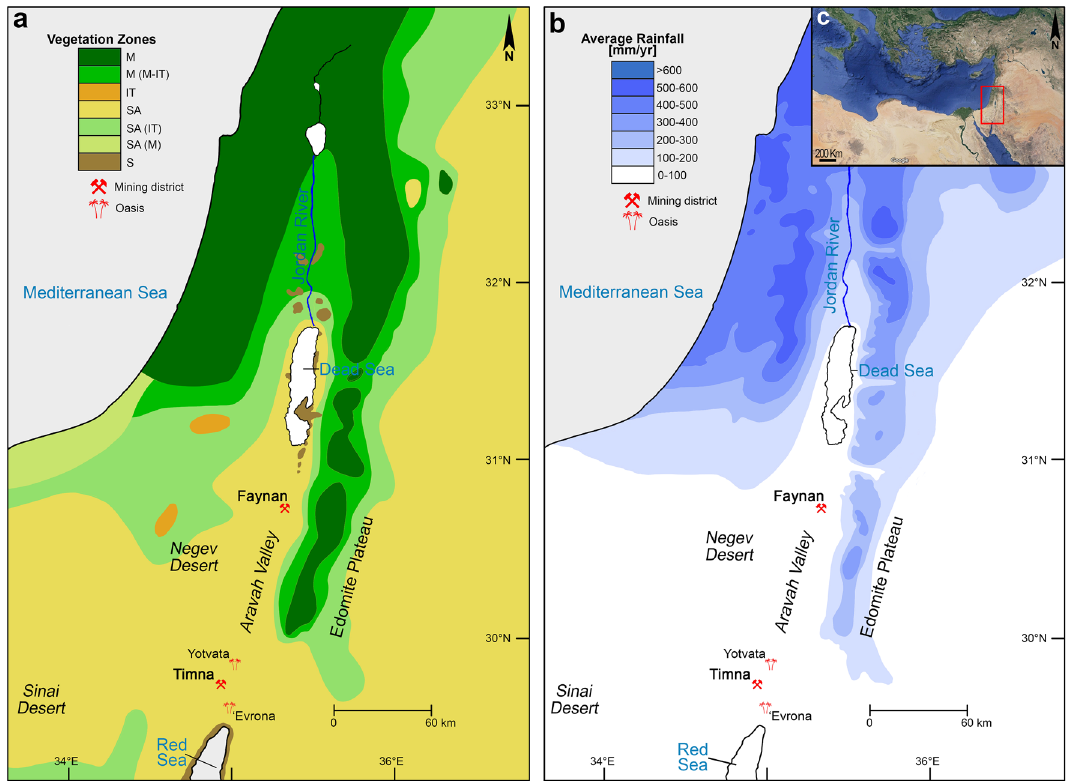
Figure 1. Phytogeographic and rainfall isohyet maps of the southern Levant indicating mentioned sites. ( a ) Distribution of phytogeograpic zones in the southern Levant; M = Mediterranean zone (garrigue, maquis, woodland); IT = Irano-Turanian zone (steppeland); SA = Saharo-Arabian zone (desert); S = Sudanian zone (penetration territory); ( b ) Map of the southern Levant indicating mean annual precipitation in mm; ( c ). Satellite image showing position of southern Levant within the Eastern Mediterranean. Phytogeographic and rainfall isohyet maps created using Adobe Photoshop 2020 ver. 21.1 [www. Adobe. com]. Phytogeographic map created according to 15–18 , rainfall map created according to 19–21 . Satellite image courtesy of Google Earth ( © 2021 Google Earth